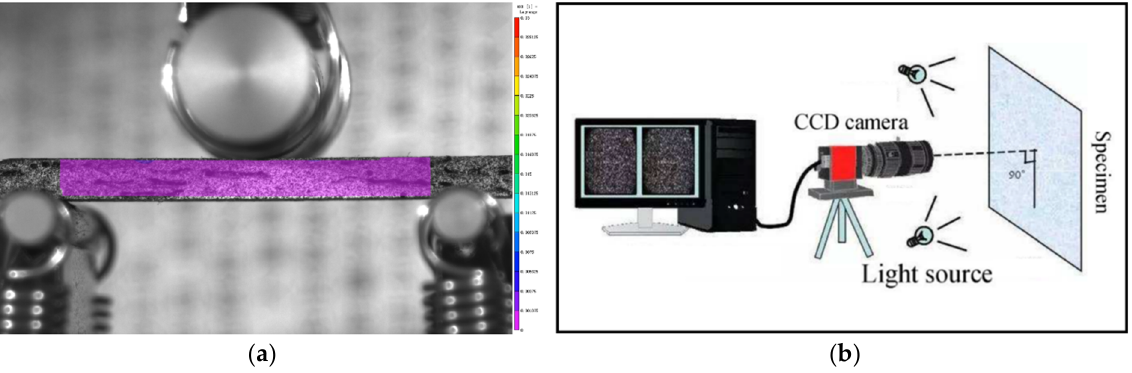
Figure 5. Experiment schematic and strain measurement methods; ( a ) for experiment schematic ( b ) for stain measurement methods. ( b ) for stain measurement